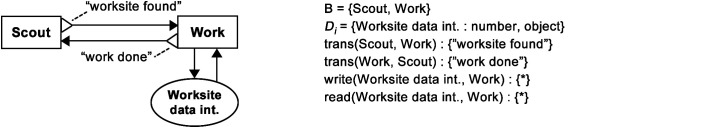
 BDRML representation of the Individualist design pattern.